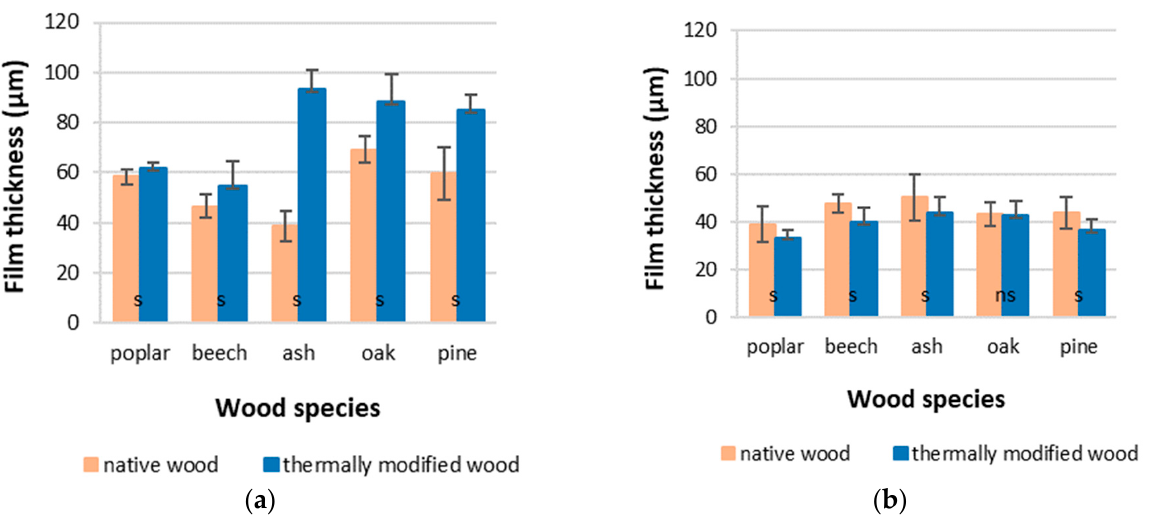
Figure 3. Film thickness after ( a ) varnishing and ( b ) oiling (s—statistically significant differences within the same species, ns—non-statistically significant differences within the same species, based on the t -test, p ≤ 0.05).